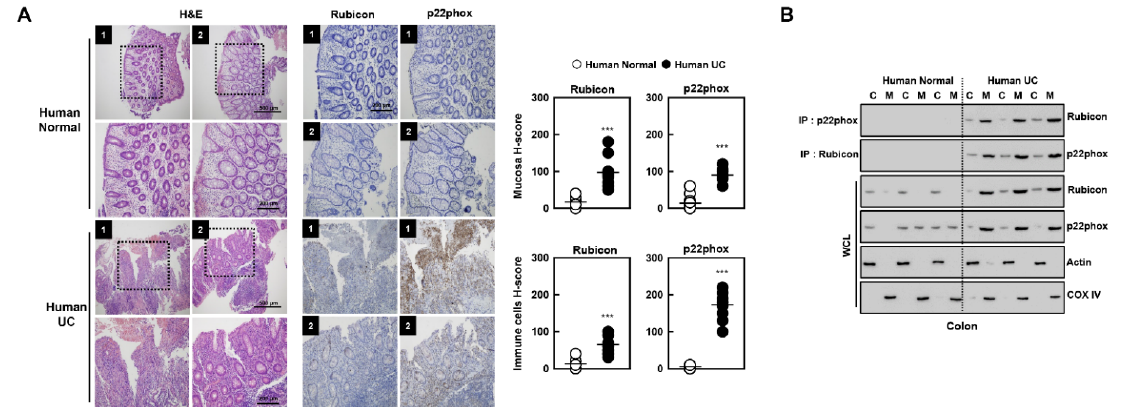
Figure 7. Mito − TIPTP alleviates chronic DSS − induced colitis in mice. ( A ) Schematic of the chronic colitis model treated 2.5% DSS with Mito − TIPTP (50 ng/kg). ( B ) The survival of mice was monitored for 9 weeks; mortality was measured for n = 15 mice per group. ( C ) Weight loss of vehicle or Mito − TIPTP in mice ( n = 15). ( D ) Image (up) and length (down) of colon in 2.5% DSS − induced chronic colitis mice with vehicle or Mito − TIPTP. (E) Representative imaging of H&E staining of the colon (left) ( n = 8). Histopathology scores were obtained from H&E staining were determined in 2.5% DSS − induced chronic colitis mice with vehicle or Mito − TIPTP. Scale bar, 100 μ m. Statistical significance was determined by Student’s t − test with Bonferroni adjustment (*** p < 0.001) compared with vehicle.